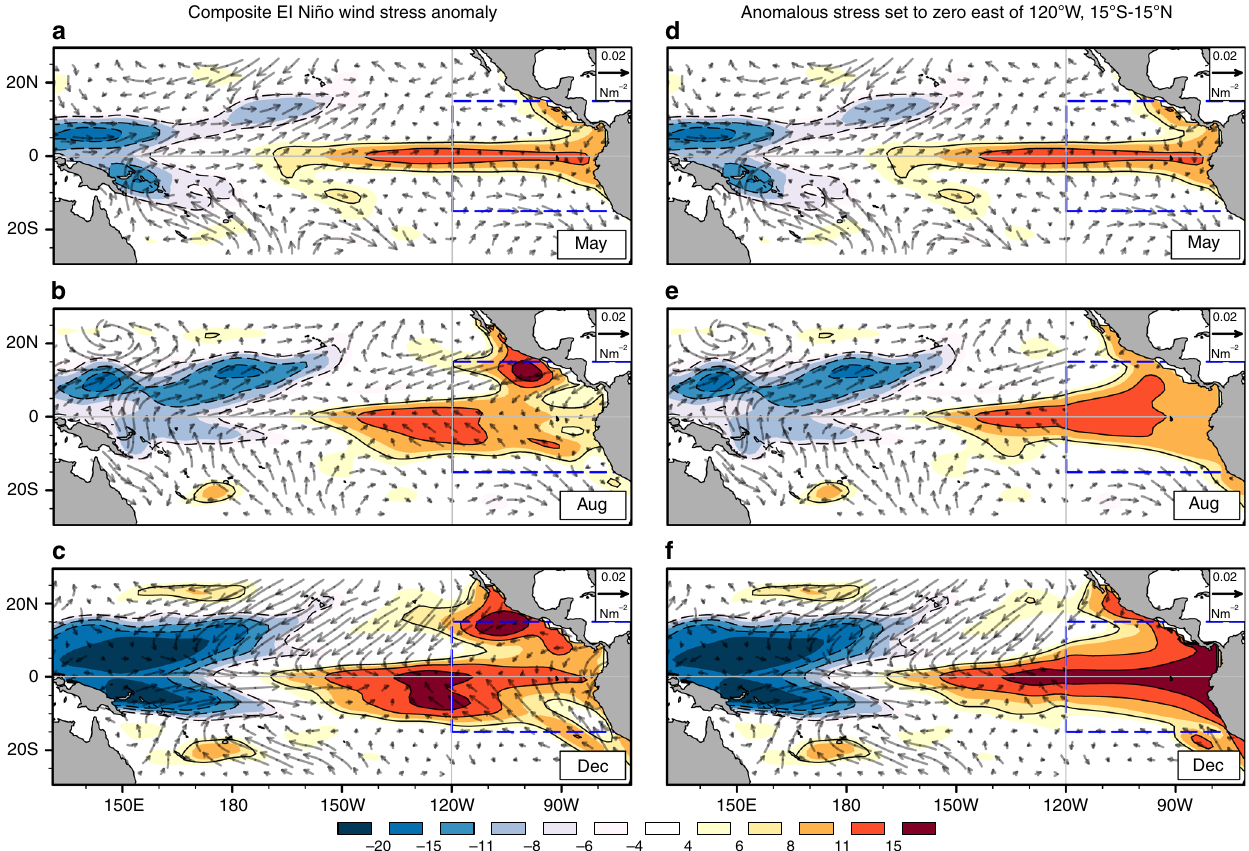
Fig. 3 The impact of far-eastern Paci fi c easterly wind stress anomalies on a simulated El Niño. Thermocline depth anomalies (shaded, units: m) from two ocean model simulations are shown for May ( a , d ), August ( b , e ), and December ( c , f ). Left: This simulation was forced with composite wind stress anomalies (vector, units: N m − 2 ) during the 1986, 1987, 1991, and 2002 El Niños. Right: In the simulation shown here, the wind forcing was modi fi ed by setting the stress anomalies in the far-eastern Paci fi c (15°S – 15°N, 120°W – 290°W) to zero, from June to December. This region (bounded by the blue dashed lines in the fi gures) was chosen, because it experienced easterly wind stress anomalies during the composite El Niño event. The simulated SST anomalies from the two experiments are shown in Supplementary Fig. 3. The maps in the fi gure were rendered with the NCAR Command Language software (https://doi.org/10.5065/D6WD3XH5) from the Global Self-consistent, Hierarchical, High-resolution Geography Database (GSHHG).